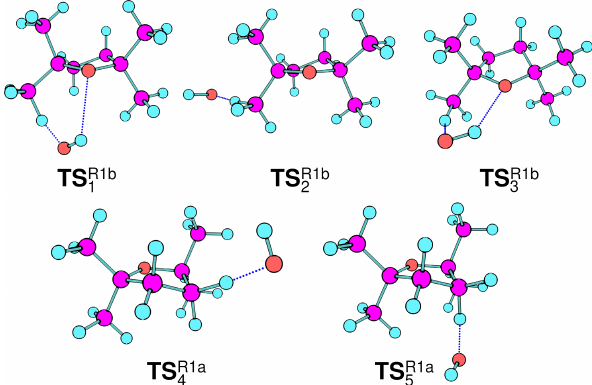
Figure 9. The five transition states (TSs) characterised via QCCs (Sect. 3.3) of which TS (R1b) , TS (R1a) , and TS (R1a) are associated 2 4 5 with “direct”, non-stabilised hydrogen abstraction, and TS (R1b) and 1 TS (R1b) are associated with stabilised hydrogen abstraction that 3 proceeds via a hydrogen-bound pre-reaction complex and TS. See Fig. 1 for description of reaction channels proceeding to Reac- tion (R1a) and (R1b) products.